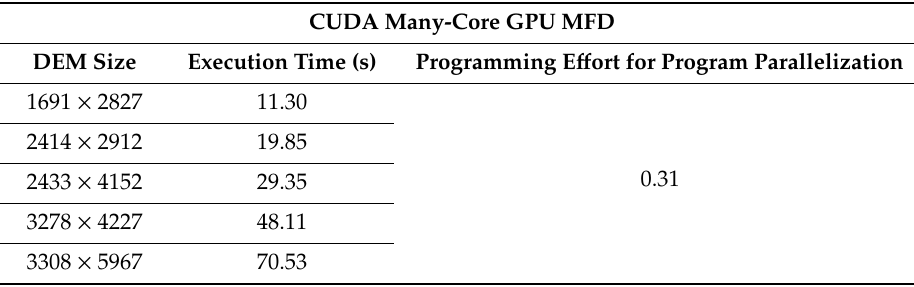
Table 3. Experimental results for CUDA many-core GPU MFD.